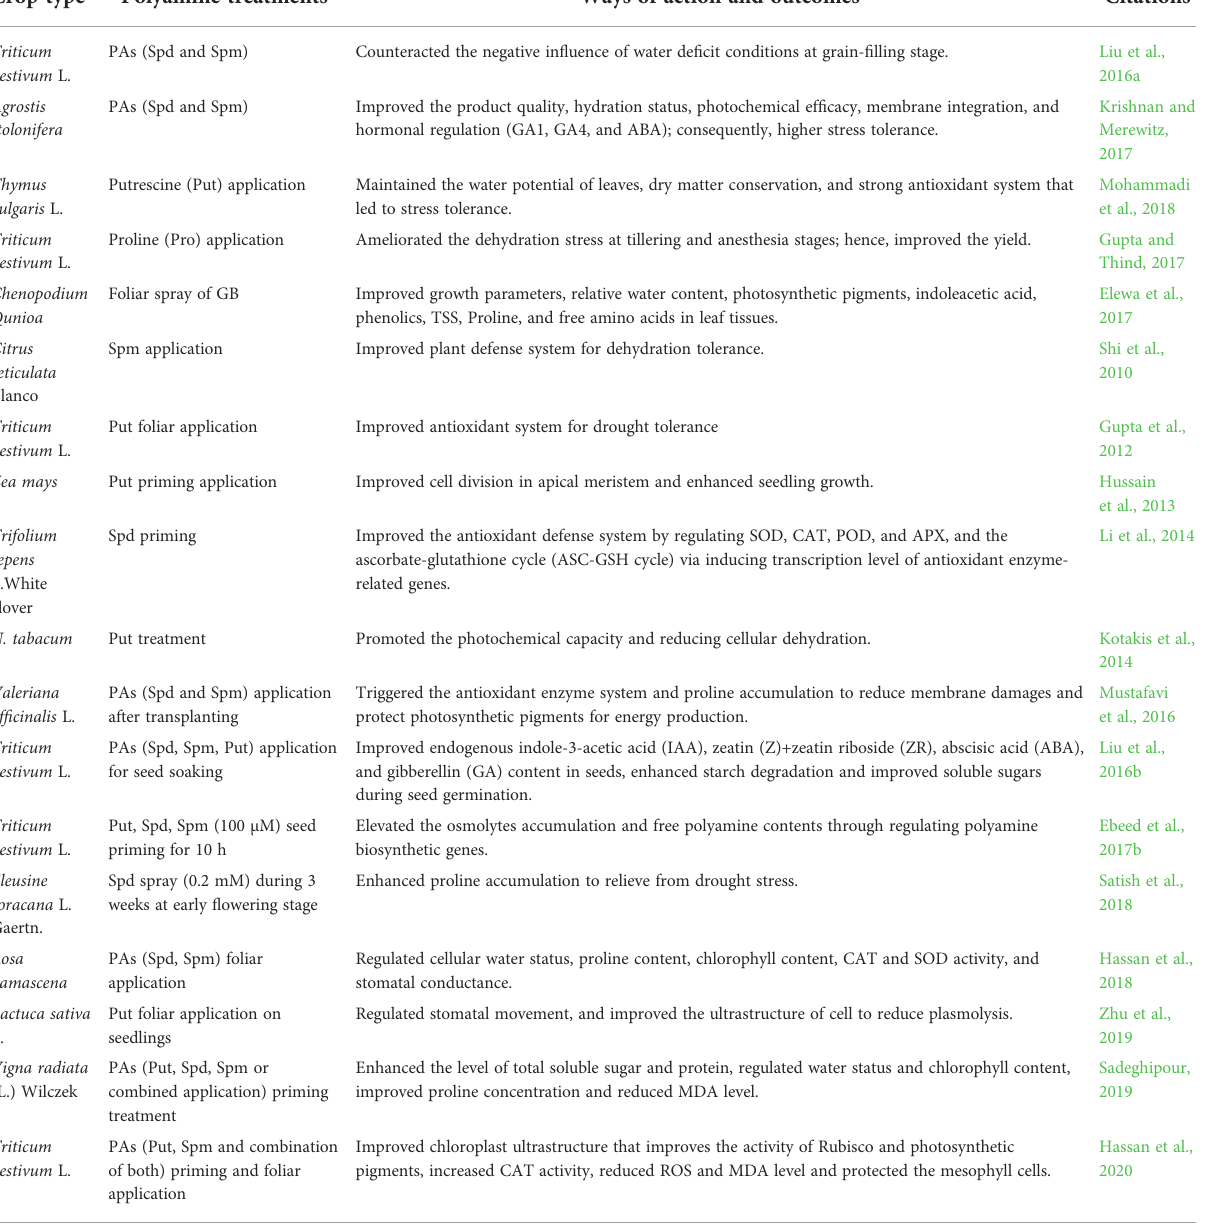
TABLE 1 Exogenous PAs application triggered desiccation resistance in different plant species. Crop type Polyamine treatments Ways of action and